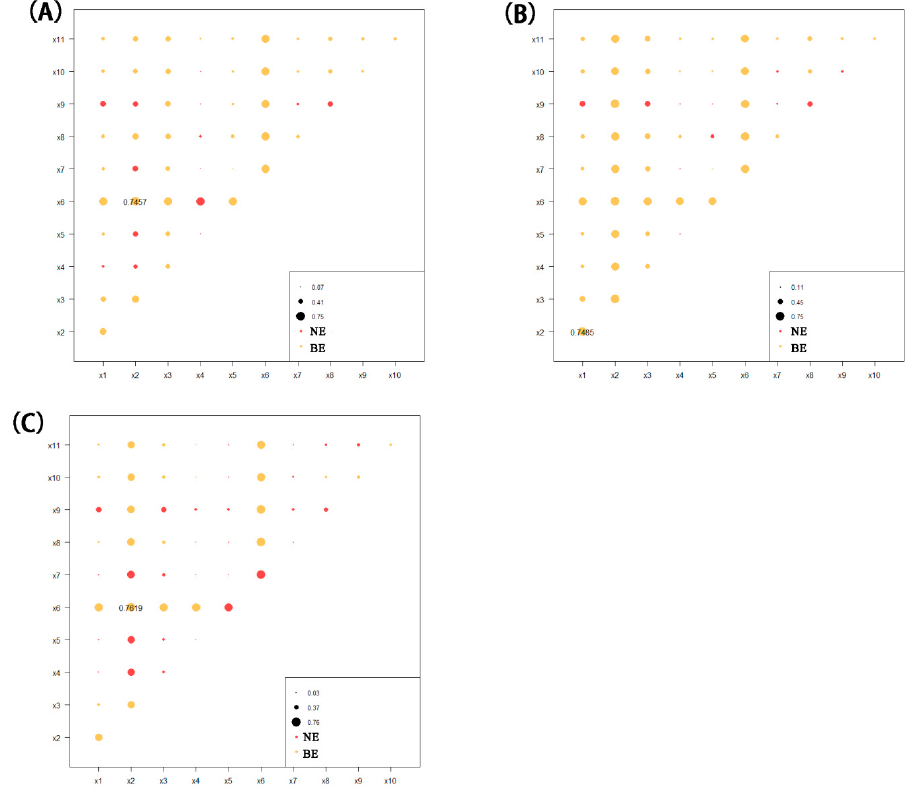
Figure 8. Results of the detection of interactions. ( A ) 2000, ( B ) 2010, and ( C ) 2020.